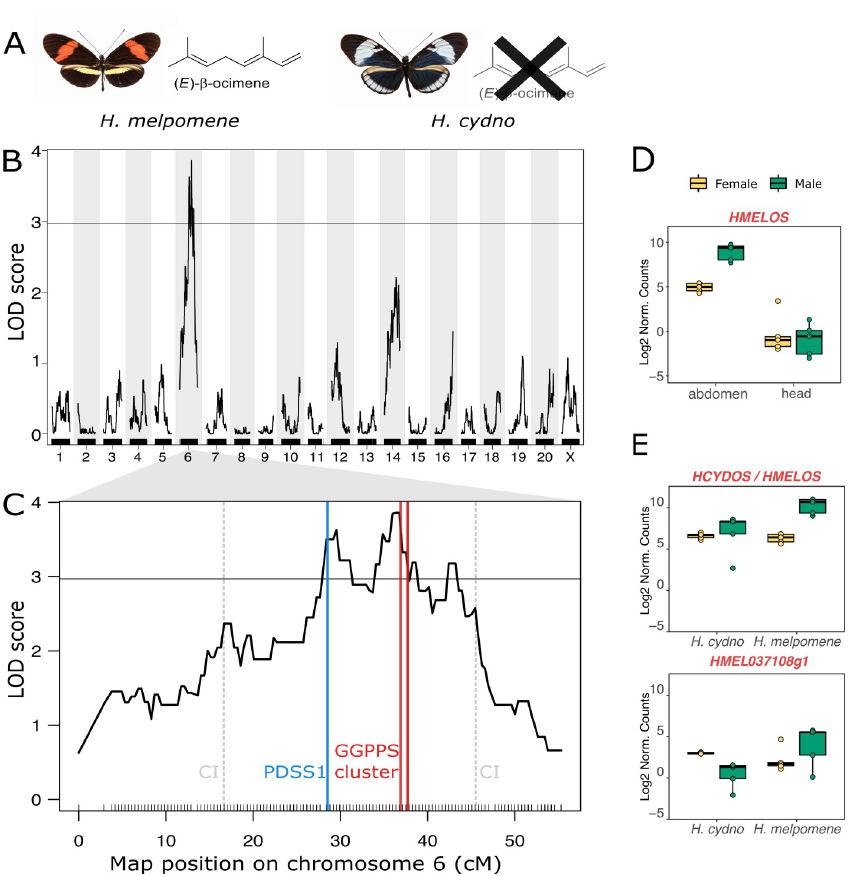
Fig 2. QTL and gene expression analyses to identify candidate genes for ( E )- β -ocimene production. (A) The 2 species used in the crosses, H . melpomene which produces ( E )- β -ocimene and H . cydno which does not. (B) Genome- wide scan for QTL underlying ( E )- β -ocimene production. (C) QTL on chromosome 6 for ( E )- β -ocimene production. CIs as well as the positions of candidate genes (subunit 1 of DPPS (PDSS1) and the GGPPS cluster) in the region are marked. Black lines above x-axis represent genetic markers, and horizontal line shows genome-wide significance threshold (alpha = 0.05, LOD = 2.97). (D) HMELOS in H . melpomene shows male abdomen-biased expression (for expression of other genes, see S3 Fig). (E) HMELOS and HMEL037108g1 both show greater male-biased expression in H . melpomene than H . cydno (for expression of other genes, see S4 Fig). Full model statistics in S2 and S3 Tables. N = 5 for each boxplot. Gene expression is given in log2 of normalised counts per million (using the TMM transformation). Sequencing data used to make linkage maps are available from the ENA study PRJEB34160. RNA-seq data of H . cydno and H . melpomene heads and abdomens was obtained from GenBank BioProject PRJNA283415. Processed data and scripts are available from OSF (https://osf.io/3z9tg/). CI, confidence interval; ENA, European Nucleotide Archive; LOD, log odds ratio; QTL, quantitative trait locus; RNA-seq, RNA sequencing; TMM, trimmed mean of M values. species � sex, t = 3.44, adjp = 0.0259; Fig 2E and S3 Table). No other genes showed a significant bias in this direction (S4 Fig and S3 Table). In summary, HMELOS and to a lesser extent HMEL037108g1 are primary candidate genes from within the QTL region.